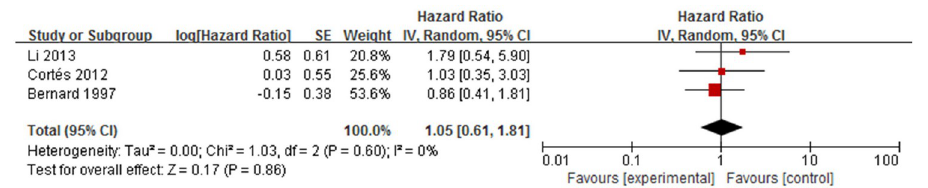
Fig 11. Forest plot of the association between positive IIF and bullous pemphigoid mortality.